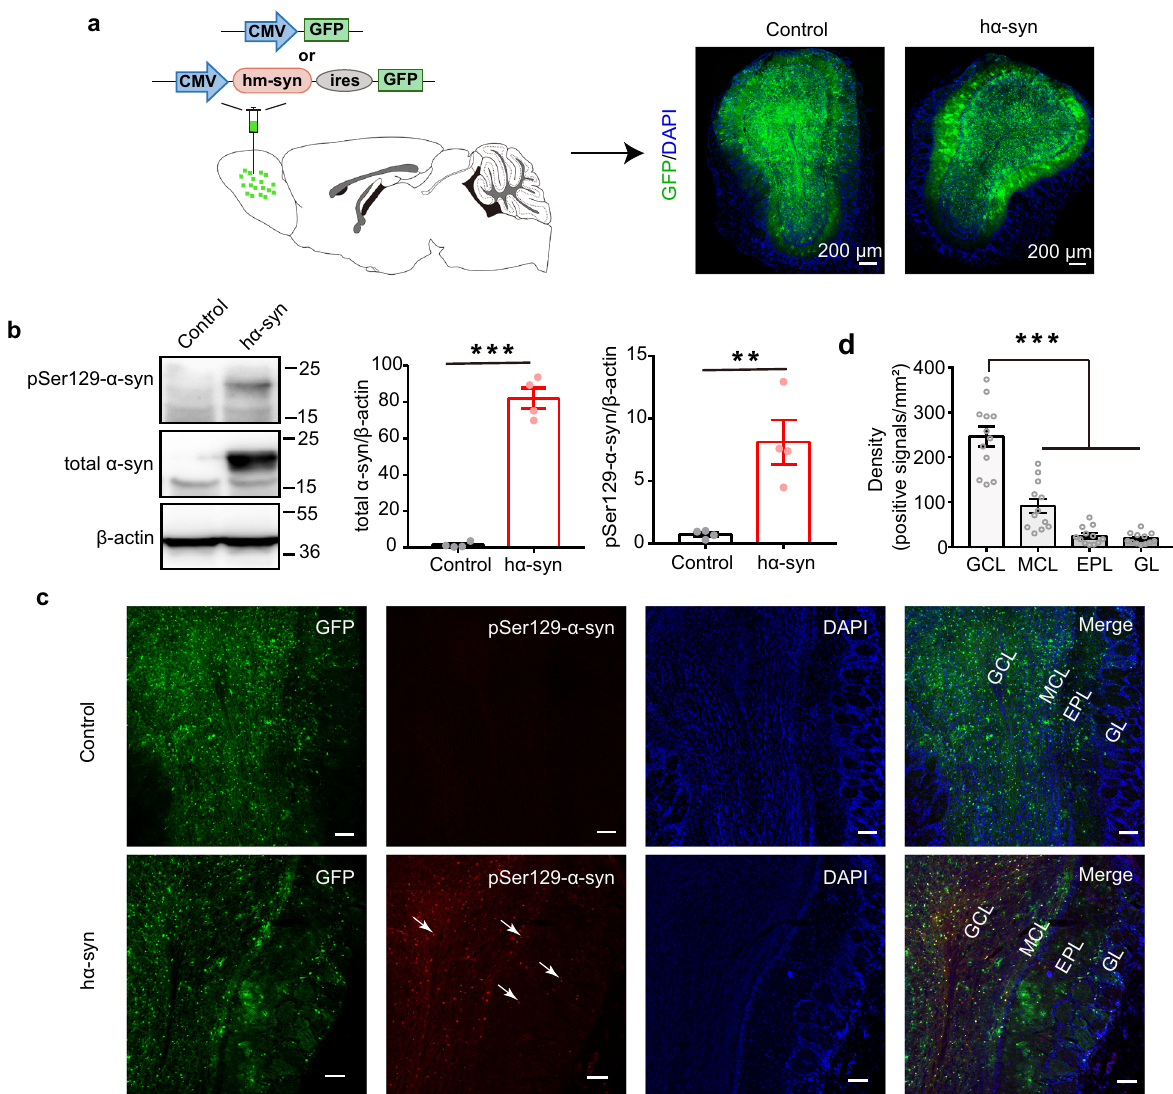
Fig. 1 Exogenous high human α -synuclein expression generates aggregates in the OB. a Schematic of the viral injections (upper) and the GFP-labeling patterns in the OB of animals injected with AAV-CMV-hm-syn-ires-GFP (h α -syn) or AAV-CMV-GFP (control) (lower). b The expression of total α -syn and pSer129- α -syn in OB tissue 3 weeks after viral injection, measured with western blots. n = 4 mice for each group. All blots derive from the same experiment and that they were processed in parallel. c Representative images showing GFP-positive, pSer129- α - syn-positive, and co-labeled cells in different layers of the OB 3 weeks after viral injection. The white arrows indicate α -syn aggregates. Scale bars = 100 μ m. d Quantitative analysis of the density of pSer129- α -syn-positive signals in different layers of OB. n = 12 slices from 4 mice for each group. GCL granule cell layer, MCL mitral cell layer, EPL external plexiform layer, GL glomerular layer, α -syn α -synuclein; ** p < 0.01; *** p < 0.001. Data are presented as mean ±